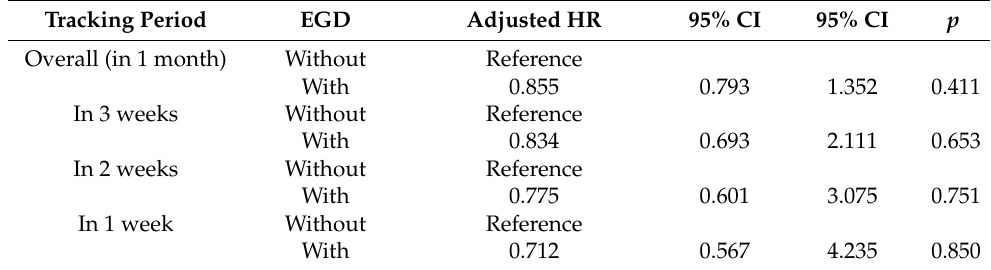
Table 4. Other covariates of outcomes in 1 month by using multivariable Cox regression.